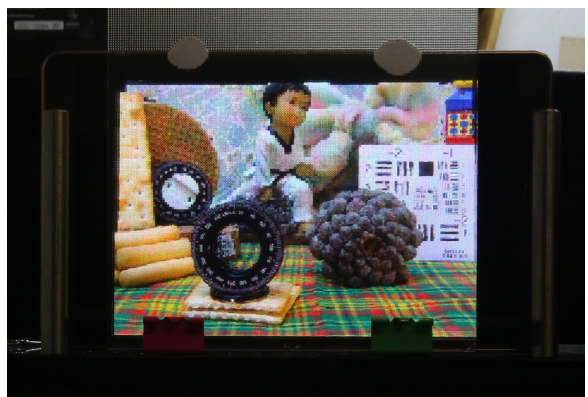
Figure 8. The integral image of Figure 7d projected in our 3D InI display prototype.